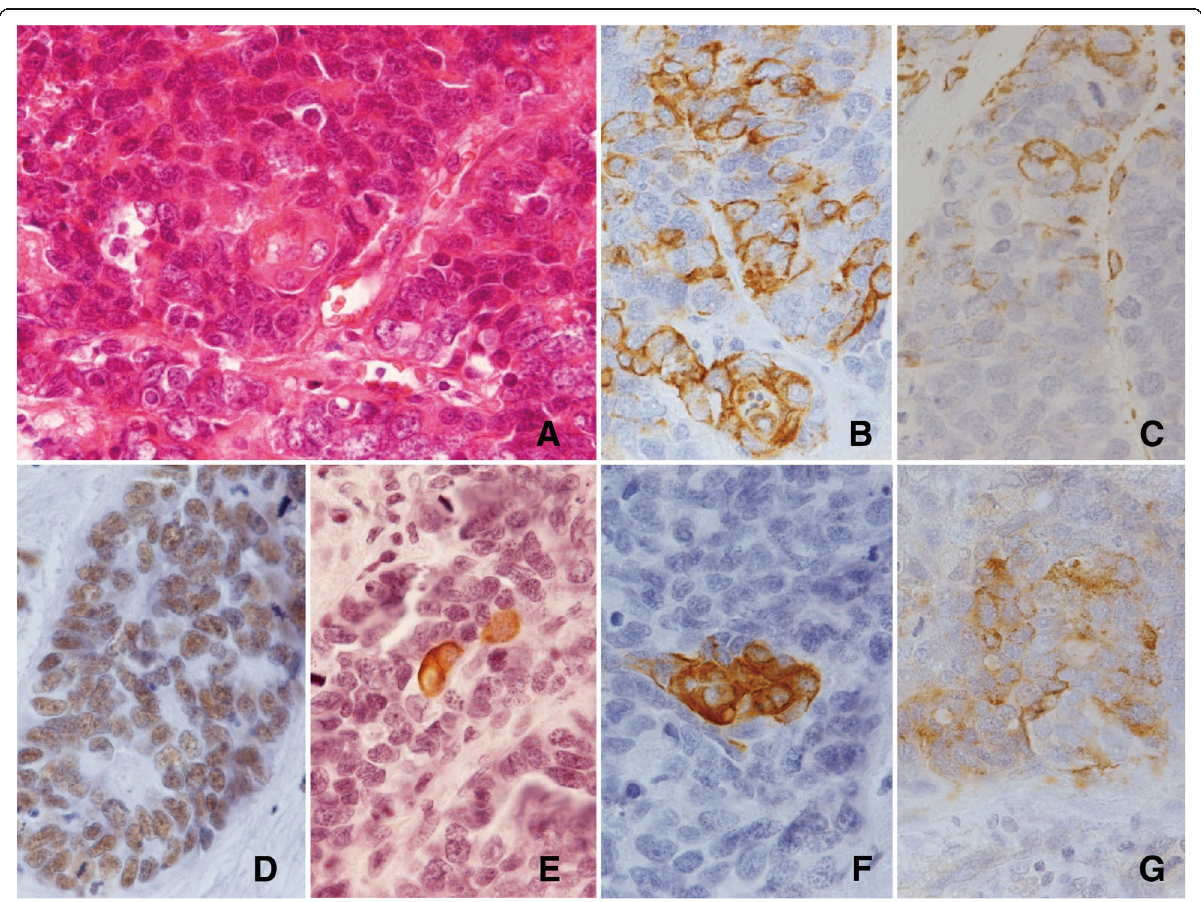
Fig. 4 Pathological findings of squamous differentiation in the lymph node ( a HE, × 400). The carcinoma cells were positive for AE1/AE3 antibodies ( b × 400) and focally positive for vimentin ( c × 400). The carcinoma cells were exclusively positive for SMARCB1 ( d ; × 400). The squamous carcinoma differentiation was positive for cytokeratin 5/6 ( e ; × 400) and anti-high molecular cytokeratin antibodies, clone 34 β E12 ( f × 400). The SCC component was positive for chromogranin A ( g ×